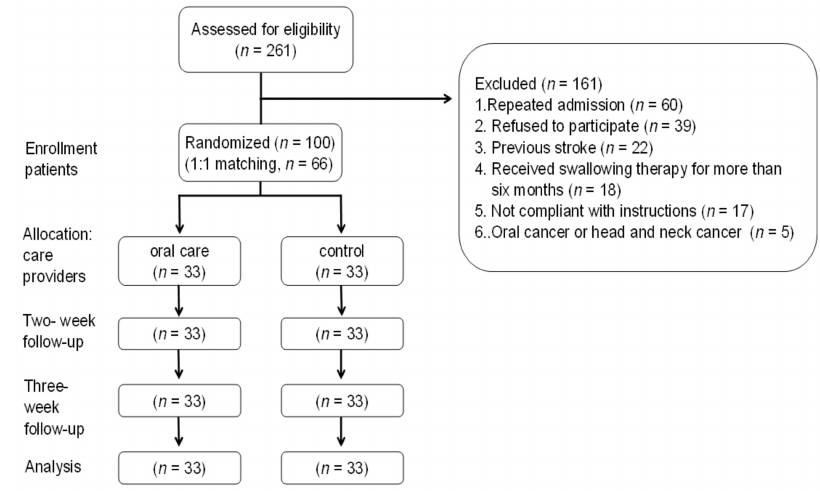
Figure 1. Consort flow diagram for oral care randomized controlled trial